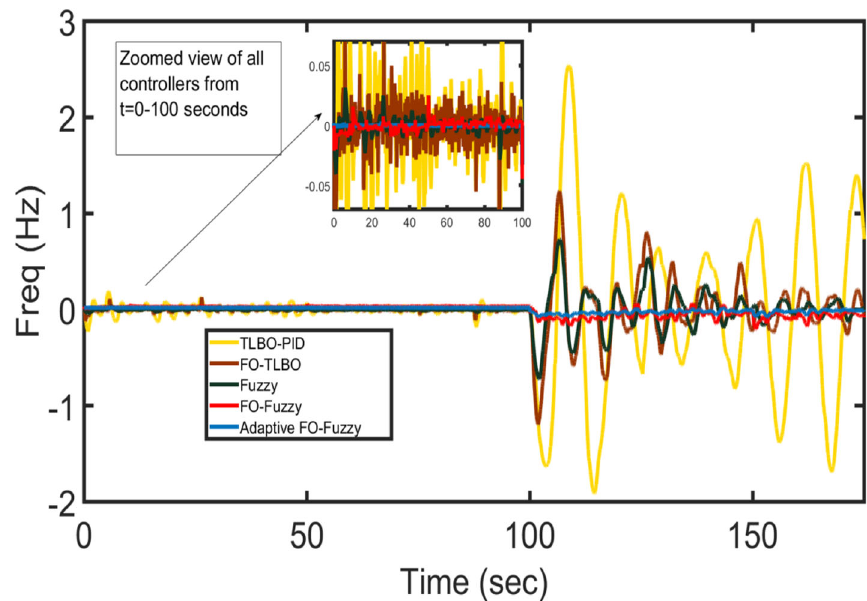
Fig. 13 ITAE performance curve for scenario 3